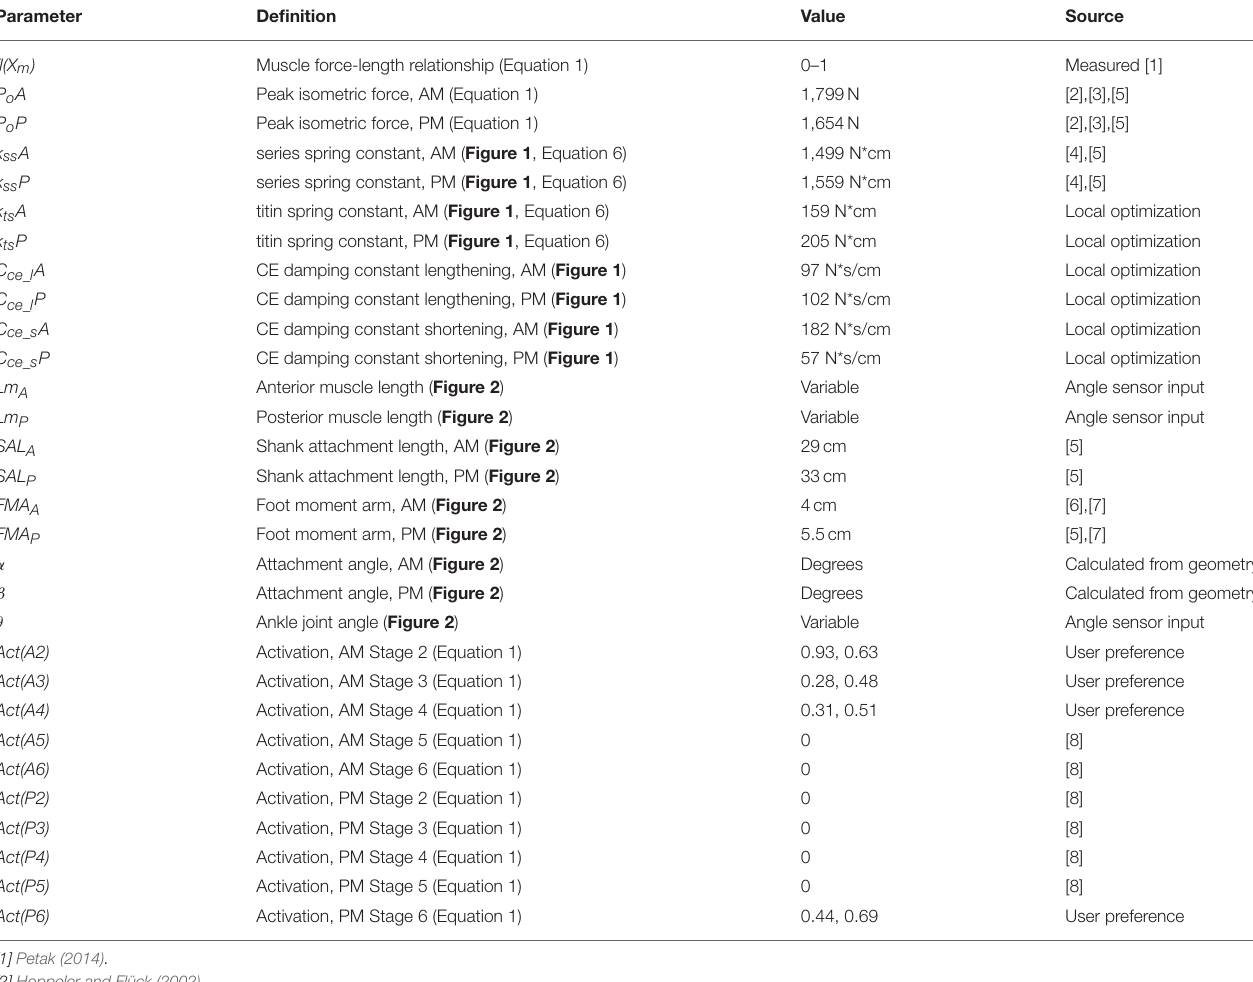
TABLE 1 | WFH controller parameters established using published values, local optimization, and/or user preference.